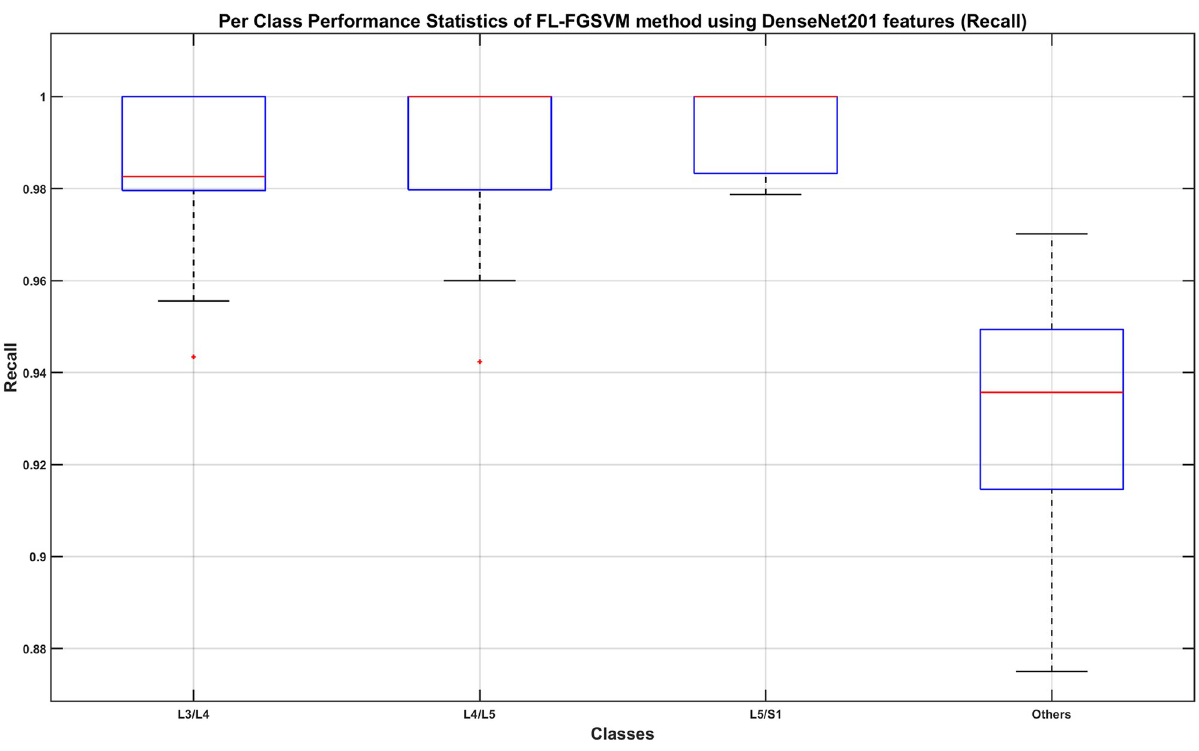
Fig 13. Per-class classification performance using Fine Gaussian SVM classifier on full-length DenseNet201 features (Recall).